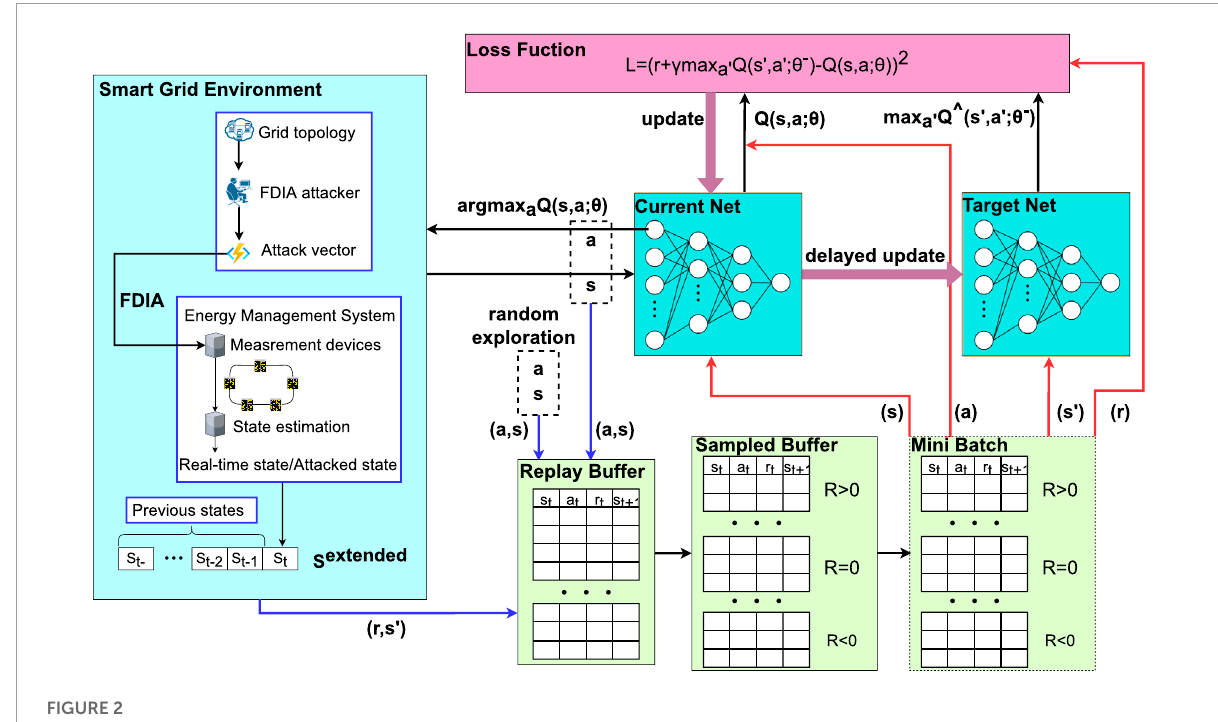
FIGURE 2 Framework of optimized DQN-based detection